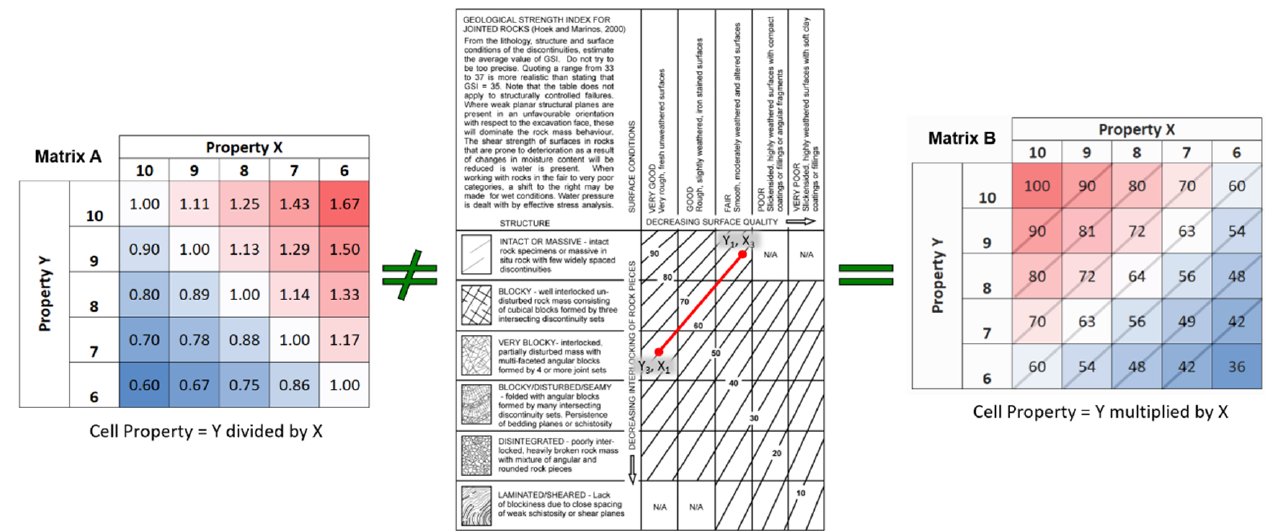
Figure 7. Comparison between Matrix A and Matrix B with the format of the GSI system [45].